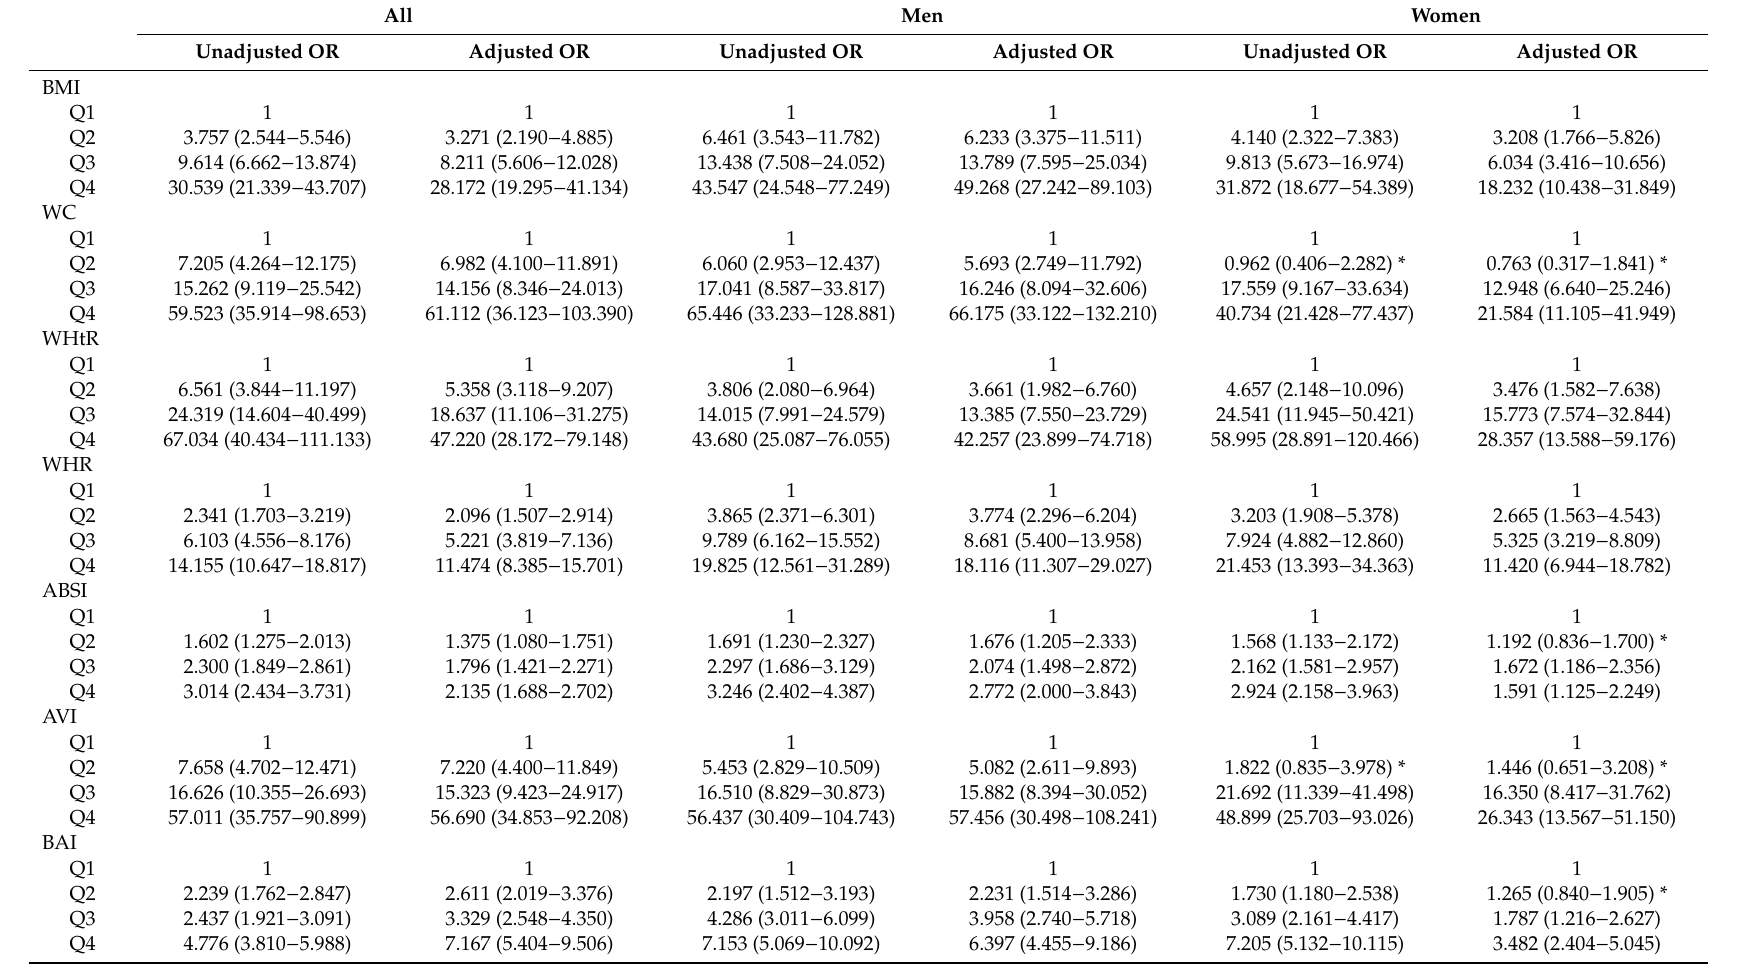
Table 2. Unadjusted and multivariate-adjusted odds ratios (ORs) for MetS stratified by quartiles of each obesity-related